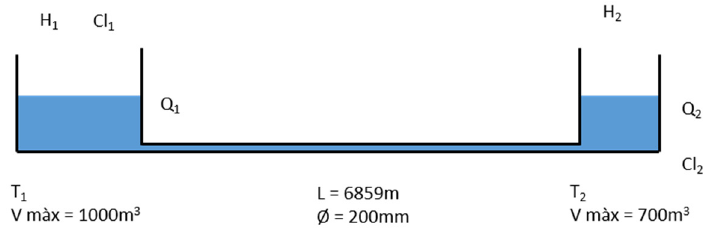
Figure 2. Outline of the network section used for the on-line calibration.